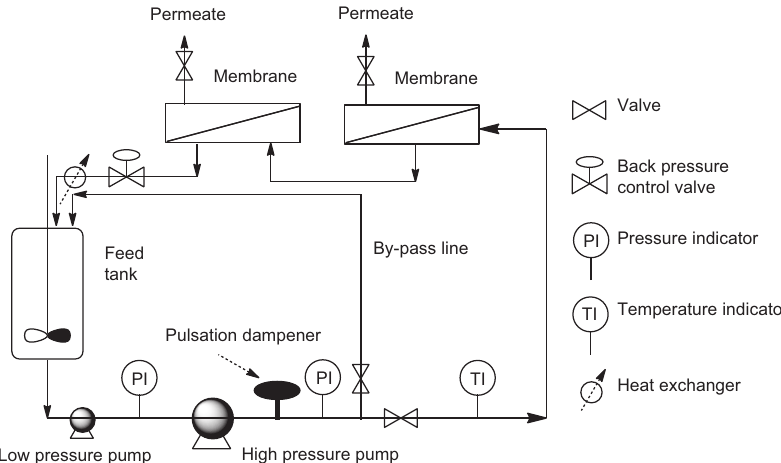
Figure 2 Nanofiltration purification skid mounted pilot